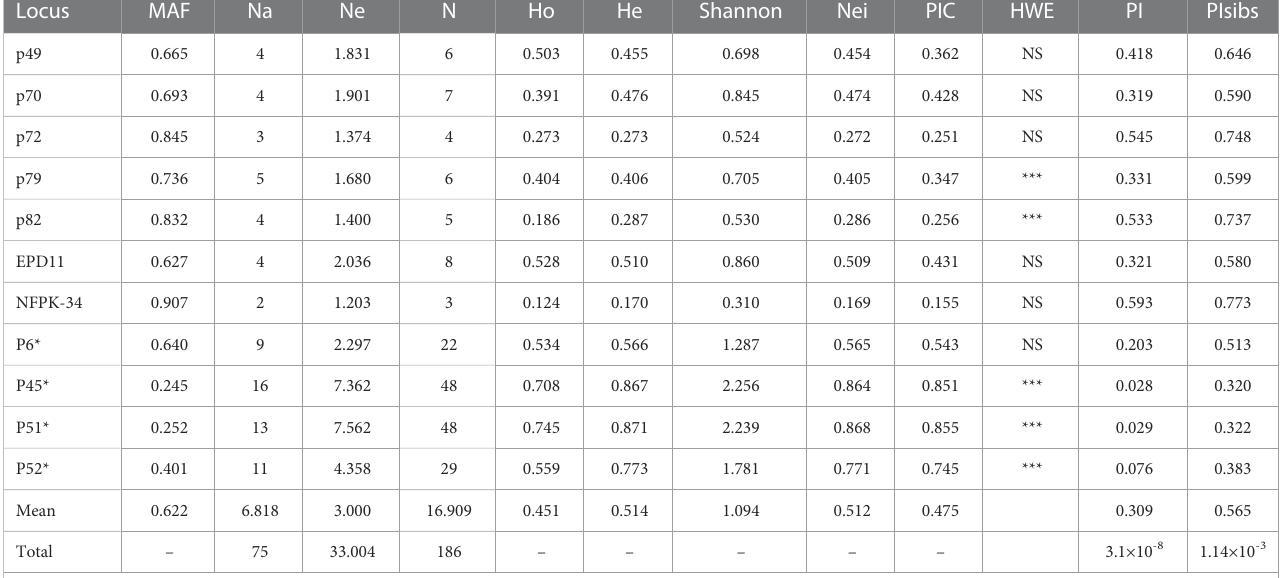
TABLE 3 Genetic diversity parameters of 11 SSR marker.